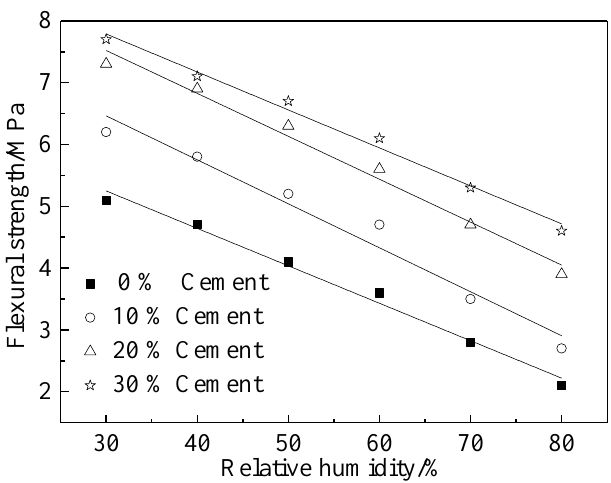
Figure 5. The relationship between flexural strength and relative humidity.